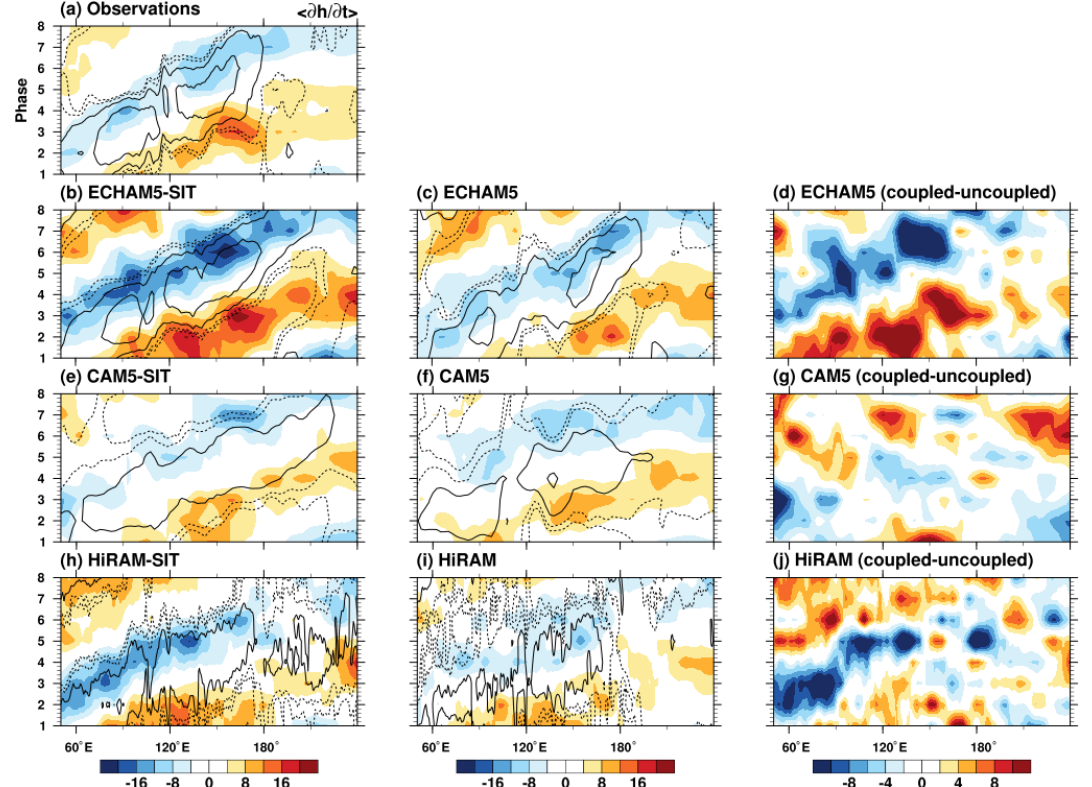
Figure 8. Hovmöller diagrams averaged over the area between 10 ◦ S and the Equator for MSE (shading; Jkg − 1 ) and precipitation (contour; mmd − 1 ) composites following the RMM index from (a) observations and simulations using the (b, e, j) coupled and (c, f, k) uncoupled AGCMs and (d, i, l) their difference. The contour interval is precipitation